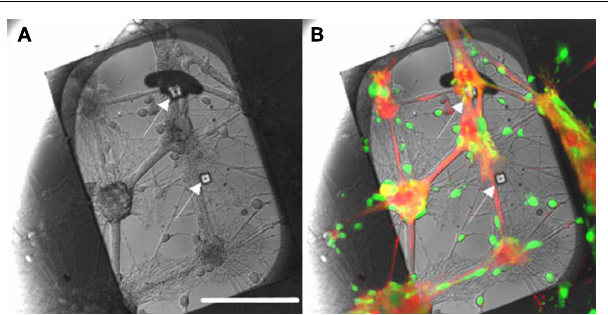
FIGURE 11 | Patch-clamp chip with two apertures (100 μ m apart), stamped with 50 μ m PDL squares. Note that subterranean microfluidic channels are not visible here.The stamp was aligned with the apertures using an aligner-bonder and stamped with a 500-g force for 1min. After 14days in vitro , cells bodies were labeled with Calcein-AM (green) and membranes withWGA conjugate (red). (A) Reflection image: apertures are indicated by arrows. (B) Superimposition of the images obtained in reflection mode and fluorescence. A neuron is positioned over the upper aperture. Scale bar: 100 μ m. From Charrier et al. (2010).